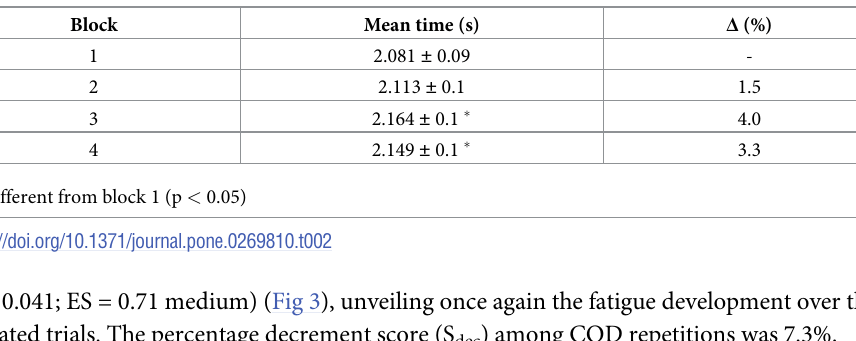
Table 2. Mean times (s) ± SD of RCOD blocks, and % difference between each block and the 1 st one.